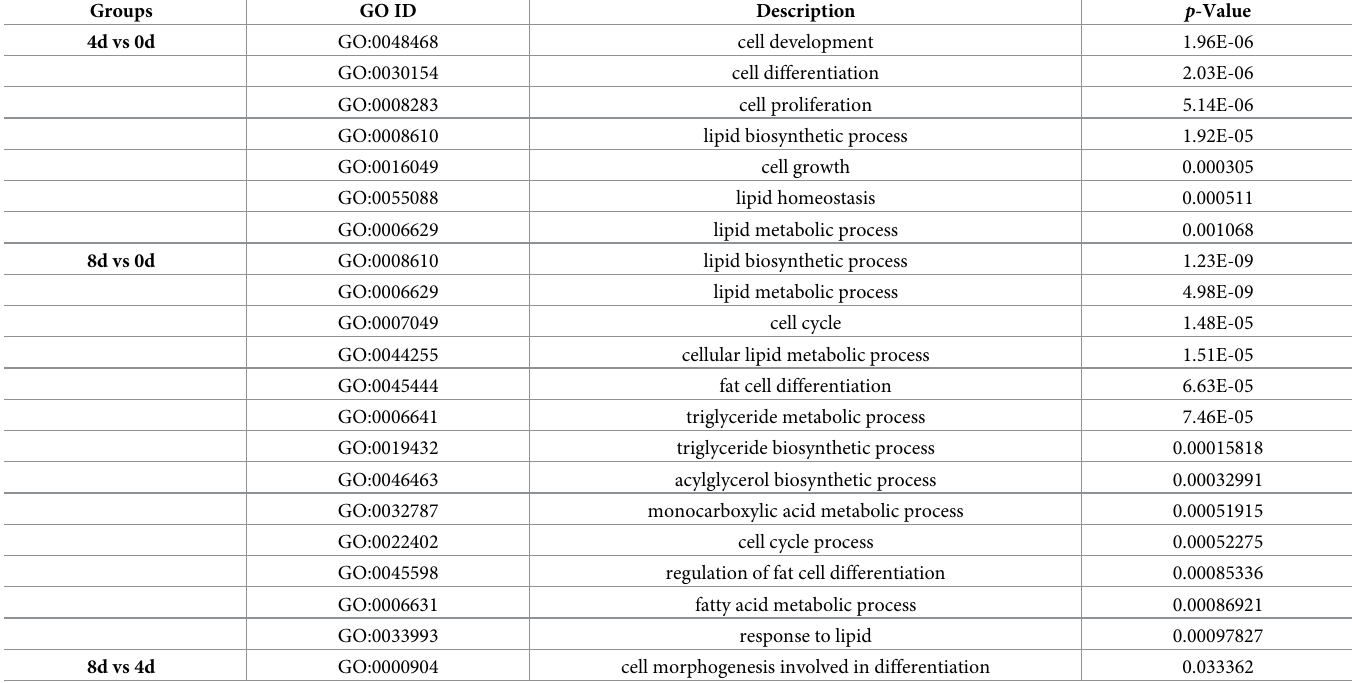
Table 2. Summary of Gene Ontology (GO) analysis of differentially expressed mRNAs. Only significant terms are listed.